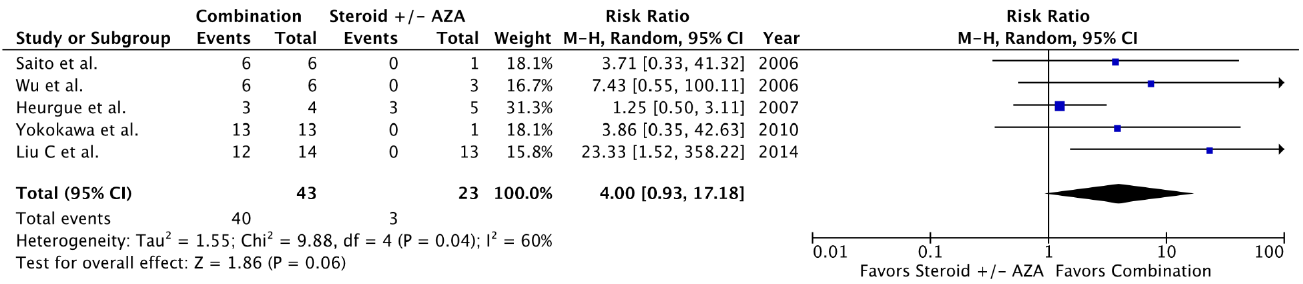
Figure 7. Biochemical improvement in AIH-PBC patients treated with combination therapy vs. immunosuppression. Steroid = corticosteroids, AZA = azathioprine, Combination = UDCA + corticosteroids ±